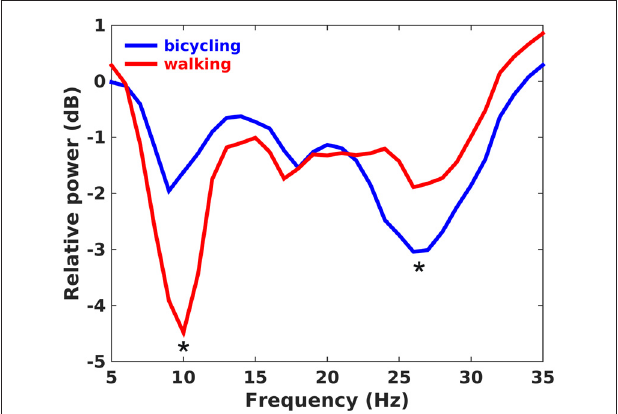
FIGURE 2 | Power ratio . Grand average plot showing changes of spectral power in dB during continuous movement relative to the baseline rest period. Positive values indicate a power increase during movement relative to baseline, whereas negative values indicate a power decrease. Alpha power decrease was stronger in walking, whereas high beta power decrease was stronger in bicycling as indicated by the